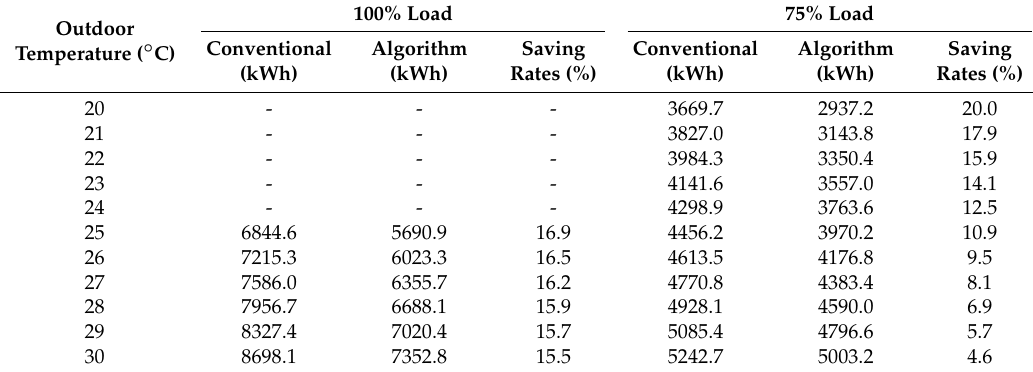
Table 7. Prediction results of energy consumption by outdoor air temperature through regression analysis.